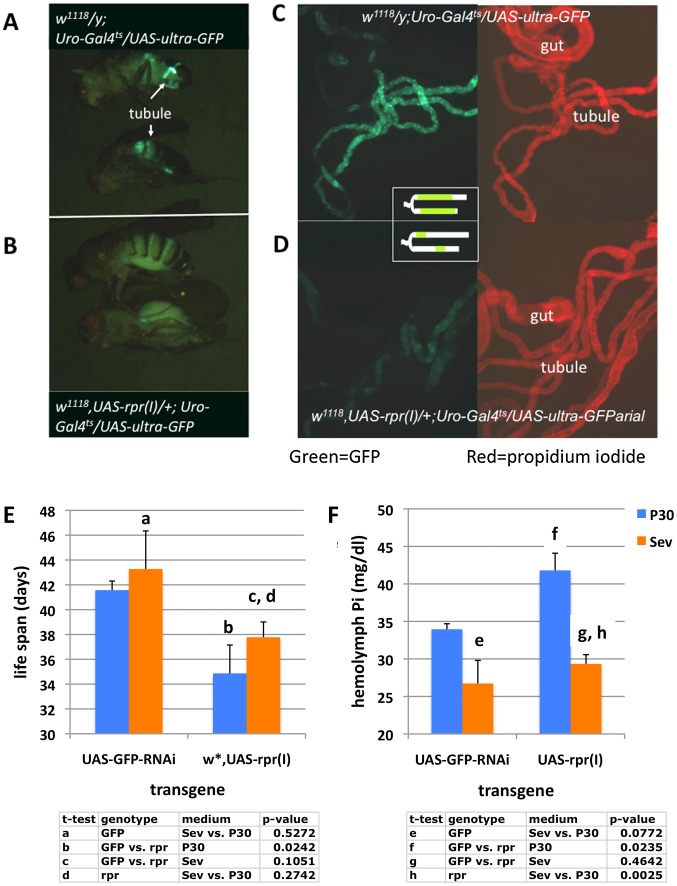
Principal cell ablation increases hemolymph phosphate and decreases life span, rescue by addition of sevelamer to the culture medium.A, B: Micrographs of 10 days old males with expression of GFP (green) in principal cells (A) or females with expression of GFP along with reaper (rpr) in principal cells after culture for ten days at 29°C (B). Epifluorescent microphotograph (10X) of tubule and gut of the same genotypes shown in A+B. Ablation of GFP-positive cells (green) by rpr is nearly complete with the exception of a few segments as shown schematically in the inset. As a consequence when compared to rpr-negative tubules (C), the majority of the tubule stained with propidium iodide (red) is made up of GFP-negative cells in (D). Median life span (E, n = 60–120 per condition) or hemolymph phosphate concentration (F, n = 3 with collections from 15 flies) of females expressing rpr or GFP-RNAi in principal cells after culture on standard medium containing 30 mM sodium phosphate (P30) normalized when cultured on 1% sevelamer (Sev1%) for 14 days.